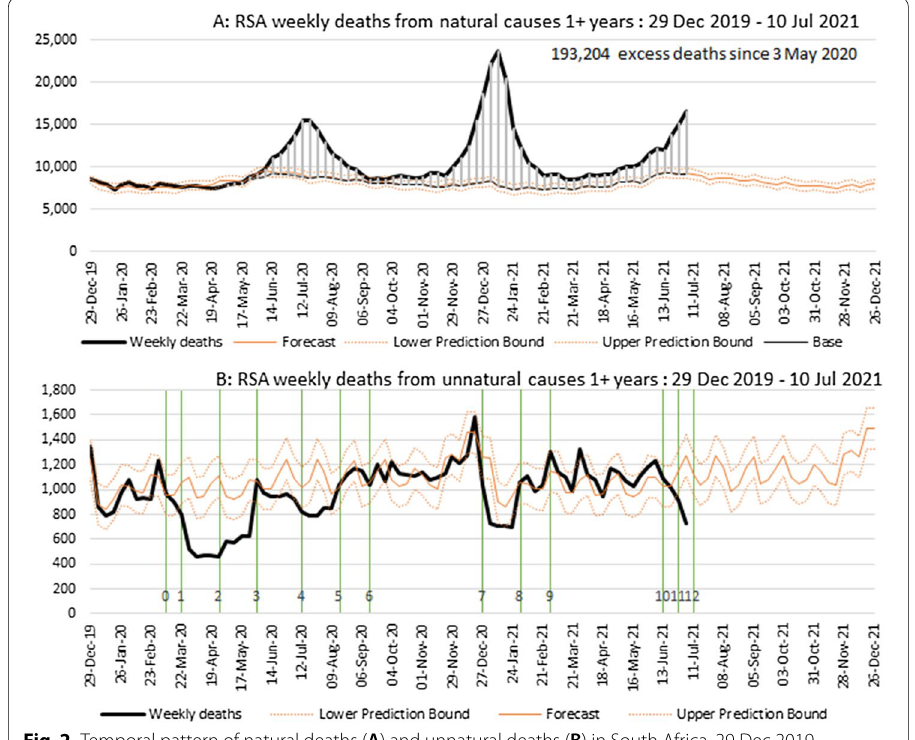
Fig. 2 Temporal pattern of natural deaths ( A ) and unnatural deaths ( B ) in South Africa, 29 Dec 2019 to 10 July 2021. Solid brown lines are the counterfactual predicted numbers with the 95% confidence intervals represented by the dotted lines. Vertical lines represent in order the week in which: 0: The